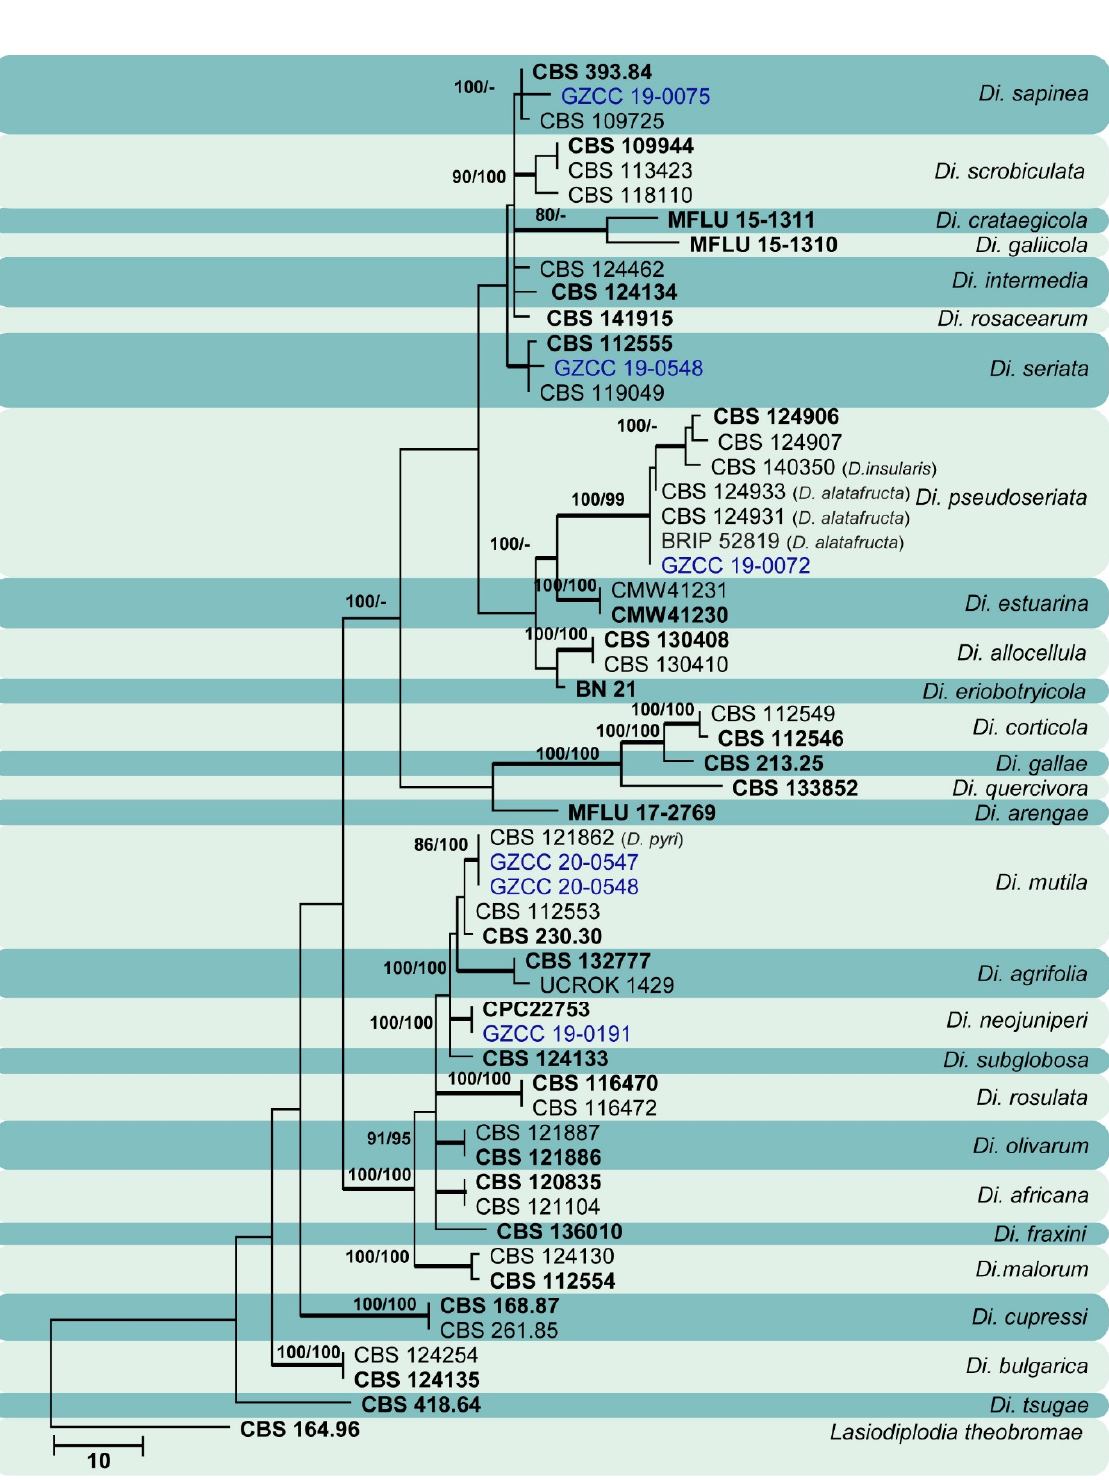
Figure 11. Maximum likelihood tree based on analysis of combined ITS and tef sequences of Diplodia . Bootstrap support values of ML, MP > 75% are shown near the nodes, and branches in bold indicate BI probabilities >0.95. Isolates obtained in this study are in blue for known species. Ex-type strains are in bold. The tree is rooted to Lasiodiplodia theobromae (CBS 164.96).